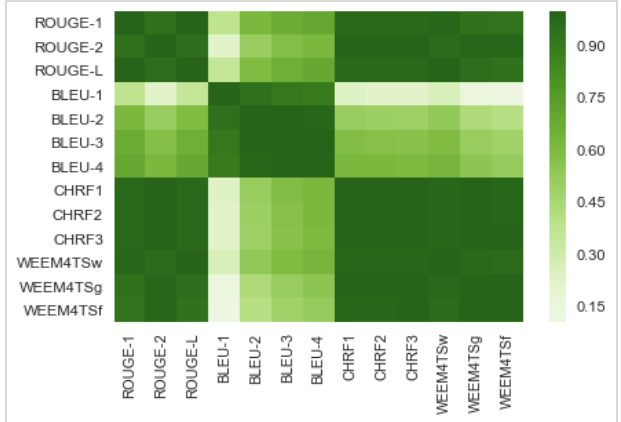
Figure 2. Performance comparison of individual best scores among variants of the metrics.